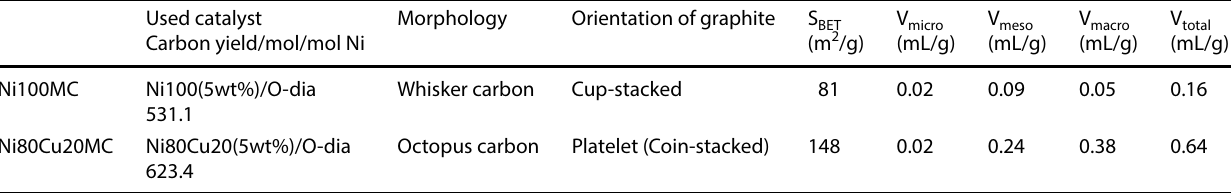
Table 1 The characteristics of the Marimo-like carbons for the RRDE measurement